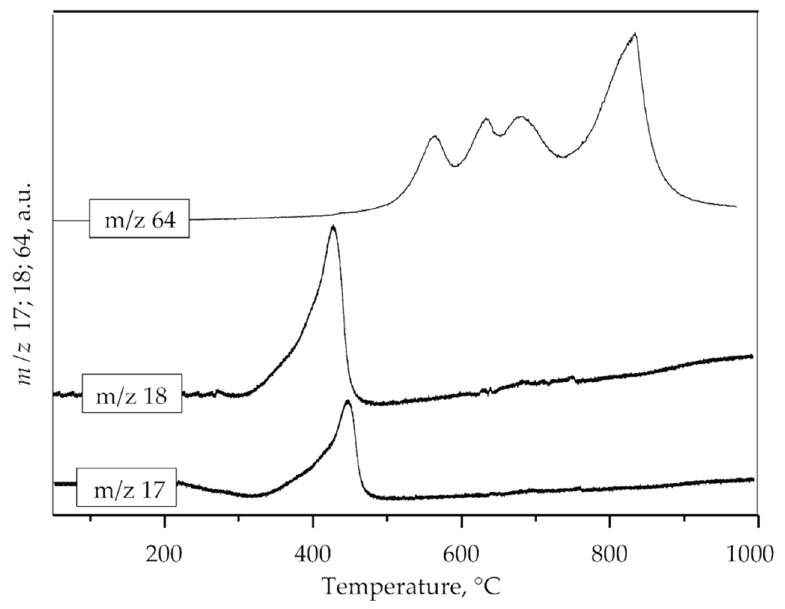
Figure 4. MS spectrum of ammonia (m/z 17), water (m/z 18) and sulfur dioxide (m/z 64). Using the formula of ammonium jarosite as (NH 4 )Fe 3 (SO 4 ) 2 (OH) 6 , the theoretical mass losses for ammonia and hydroxyl units as H 2 O are about 25 wt.%. of jarosite-PbAg sludge was determined (Table 3). Table 3. The phase composition of the jarosite-PbAg sludge. Phases Content, wt.%